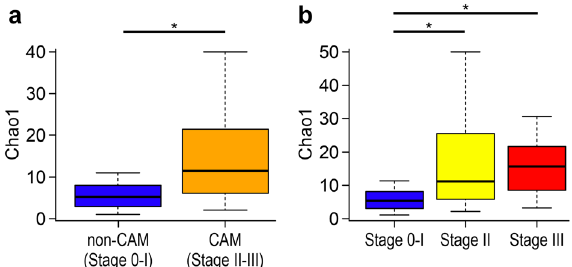
Figure 1. Chao1 indices. Sequences were clustered into operational taxonomic units with a 97% identity threshold, and the α diversity index (Chao1) was calculated for each sample. Chao1 was significantly higher in the CAM than in the non-CAM group. Chao1 was significantly lower in the stage 0–I group than in the other groups. Two-tailed probabilities were calculated by the Mann–Whitney test. * P < 0.05. CAM